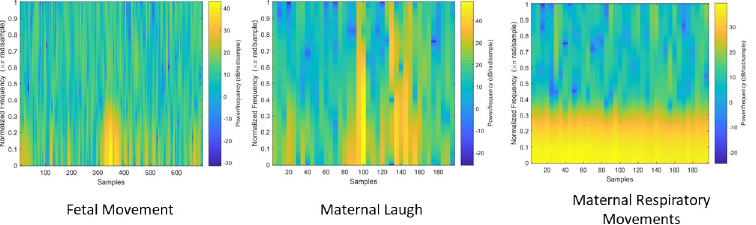
Fig 12. The resulting spectrograms of the three classes. The filtered time domain signal was fed in to a Short Time Fourier Transform (STFT) algorithm and the resulting figures are shown here. A figure of each type of realization can be observed and these figures are generated based on the output matrix of the STFT algorithm. The amplitude of the output matrix was utilized and the different colours corresponds to the amplitude level of each frequency at each